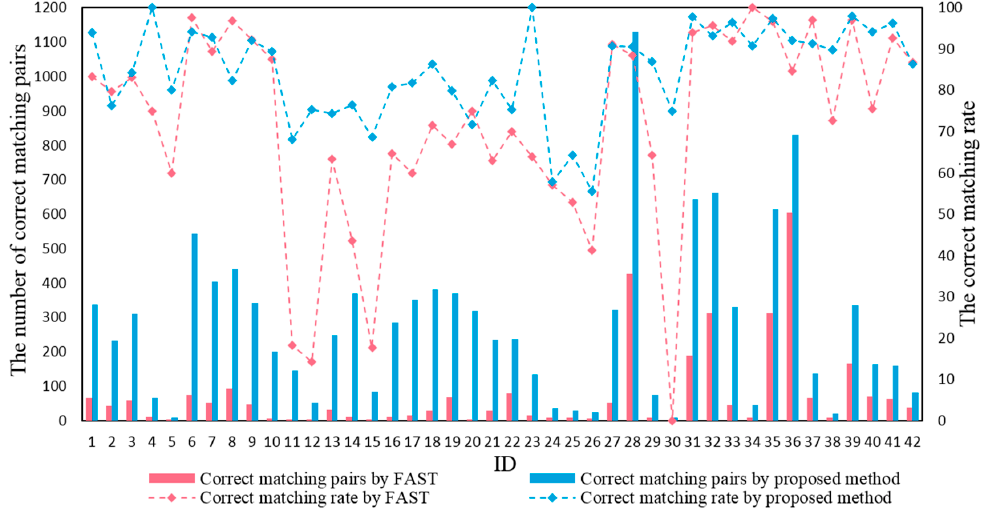
Figure 14. Effect of histogram specification within windows.